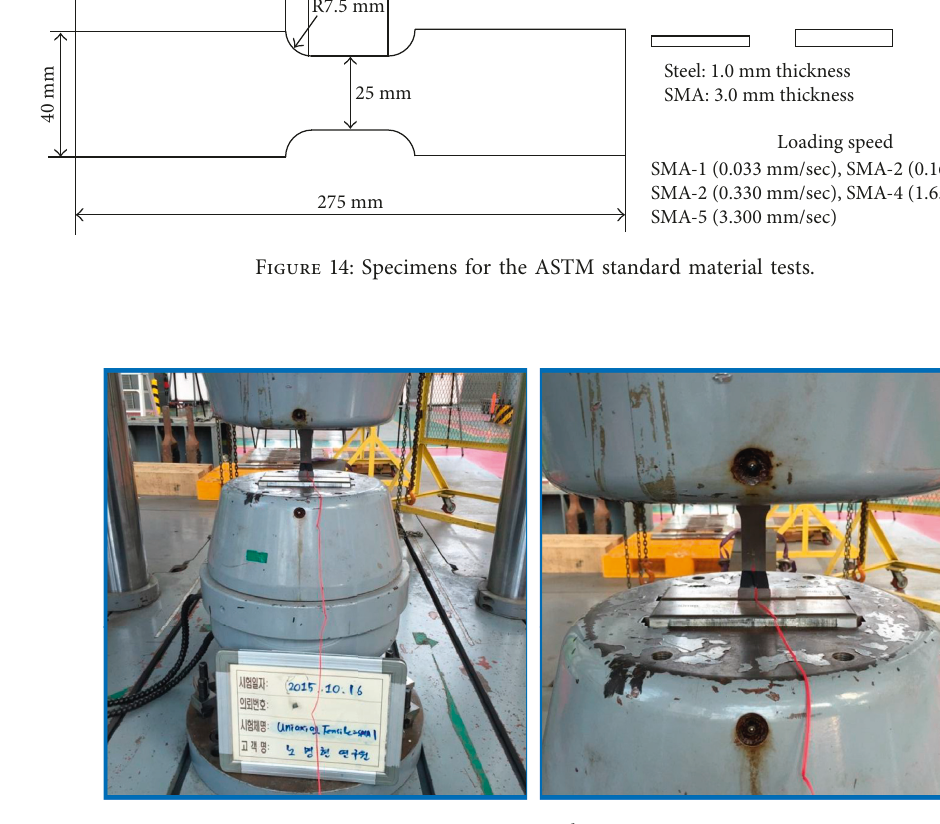
Figure 15: Material test